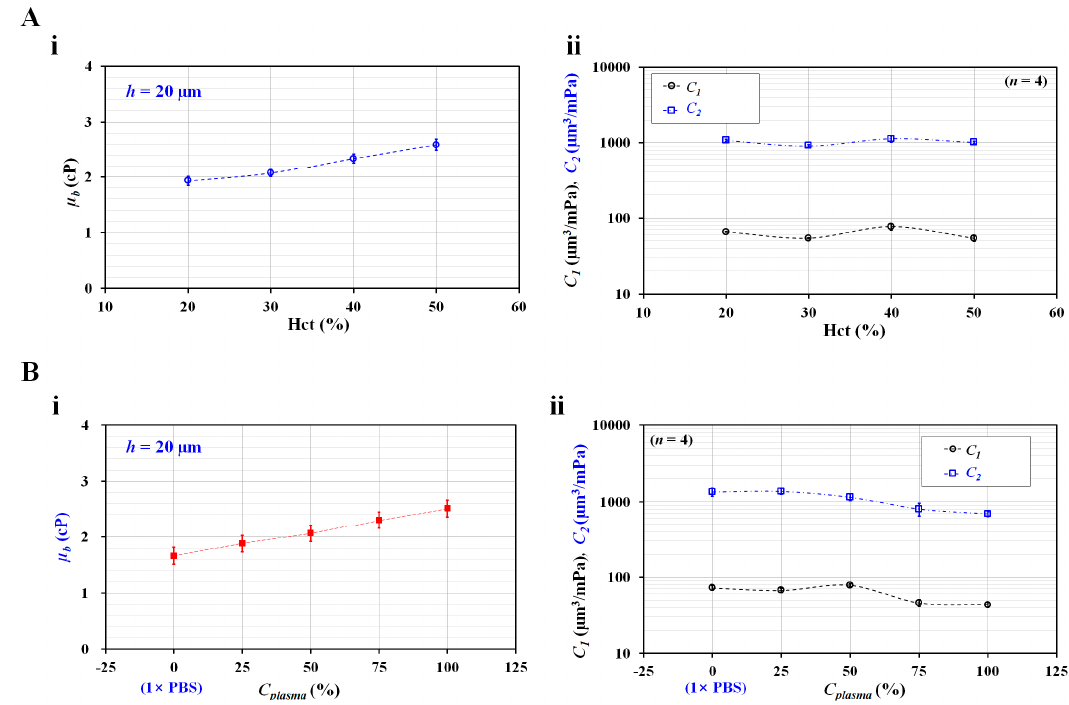
Figure 5. Contributions of hematocrit and diluted plasma to blood viscosity ( µ b ) and two compliances ( C 1 and C 2 ). Hematocrit of suspended blood was adjusted by adding normal RBCs into autologous plasma. Autologous plasma was diluted with 1 × PBS. Channel depth was fixed at h = 20 µ m. ( A ) Contributions of hematocrit (Hct = 20%, 30%, 40%, and 50%) to blood viscosity ( µ b ) and two compliances ( C 1 and C 2 ). ( i ) Variations of µ b with respect to Hct. ( ii ) Variations of two compliances ( C 1 and C 2 ) with respect to Hct. ( B ) Contributions of diluted plasma to blood viscosity ( µ b ) and two compliances ( C 1 and C 2 ). ( i ) Variations of µ b with respect to plasma concentration ( C plasma ) ( C plasma = 0%, 25%, 50%, 75%, and 100%). C plasma = 0% and C plasma = 100% denote pure 1 × PBS